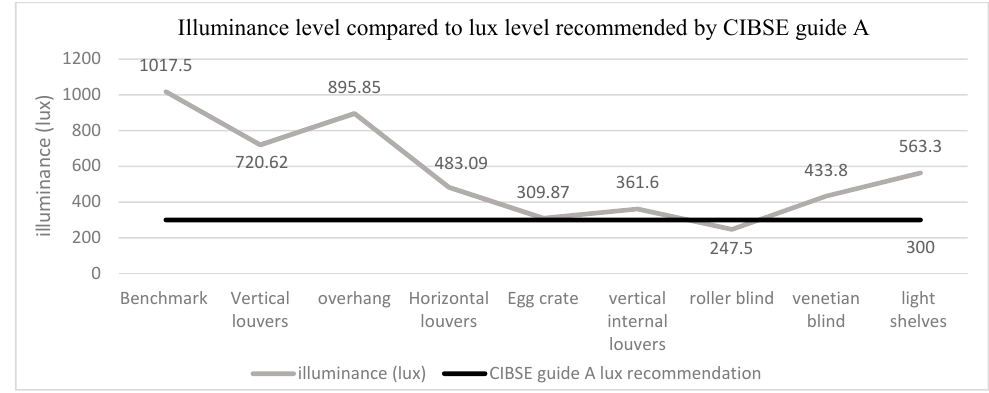
Figure 6. Illuminance level of shadings compared to CIBSE value.